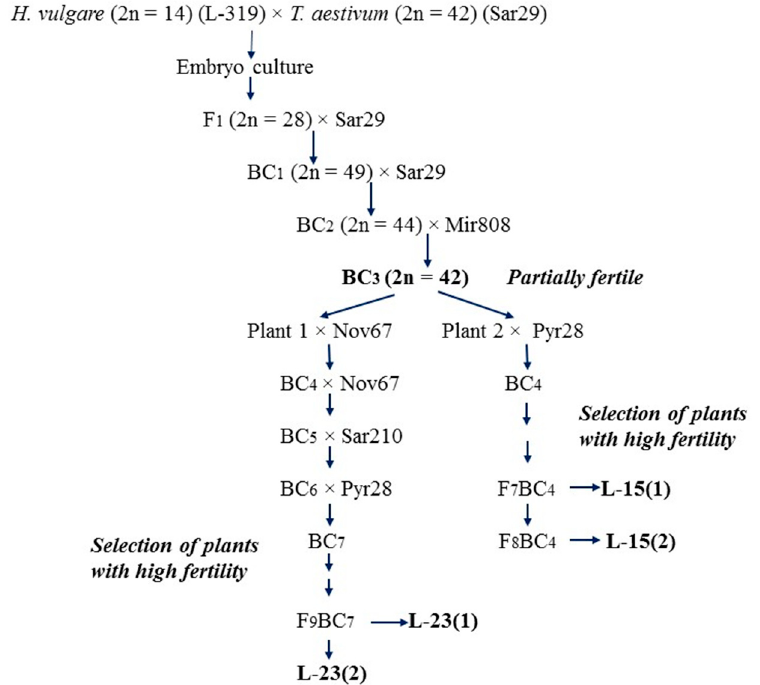
Figure 1. The scheme for the production of alloplasmic recombinant ( H. vulgare )- T. aestivum lines L-15(1), L-15(2), L-23(1), L-23(2). (L-319: barley line; varieties of bread wheat: Sar29: Saratovskaya 29; М ir808: Mironovskaya 808; Pyr28: Pyrotrix 28; Sar210: Saratovskaya 210; Nov67: Novosi- birskaya 67).